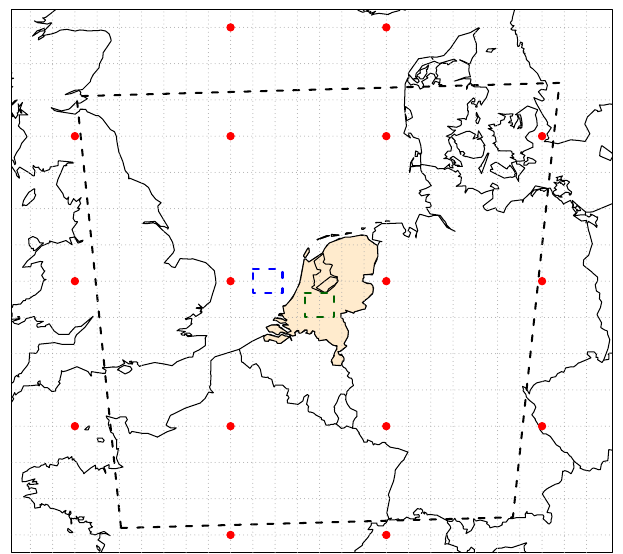
Figure 1. Map of part of Europe showing the 16 (red) points used in the circulation type classification, the WRF model domain (black), and the land (green) and sea (blue) area used for averaging in the selection procedure.